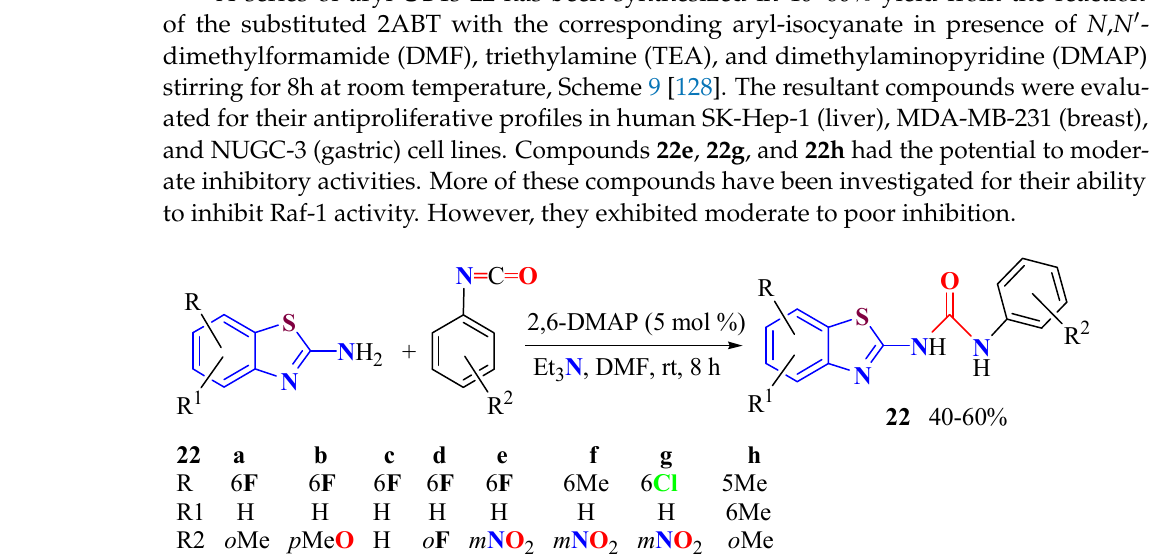
Scheme 9. 6-substituted and 5,6-disubstituted Aryl-UBTs from 2ABTs and arylisocyanates. The 1,1-bistrifluoromethyl-1-alkyl-UBTs 23a – c was prepared by addition of 2ABT to the corresponding bis-fluoroalkyl-isocyanates, Figure 4 [129]. These UBTs were evaluated for their in vitro antiproliferative activities against the human cancer cell lines. The most sensitive cell lines relative to the tested compounds were: 23c SNB-75 (CNS cancer, log